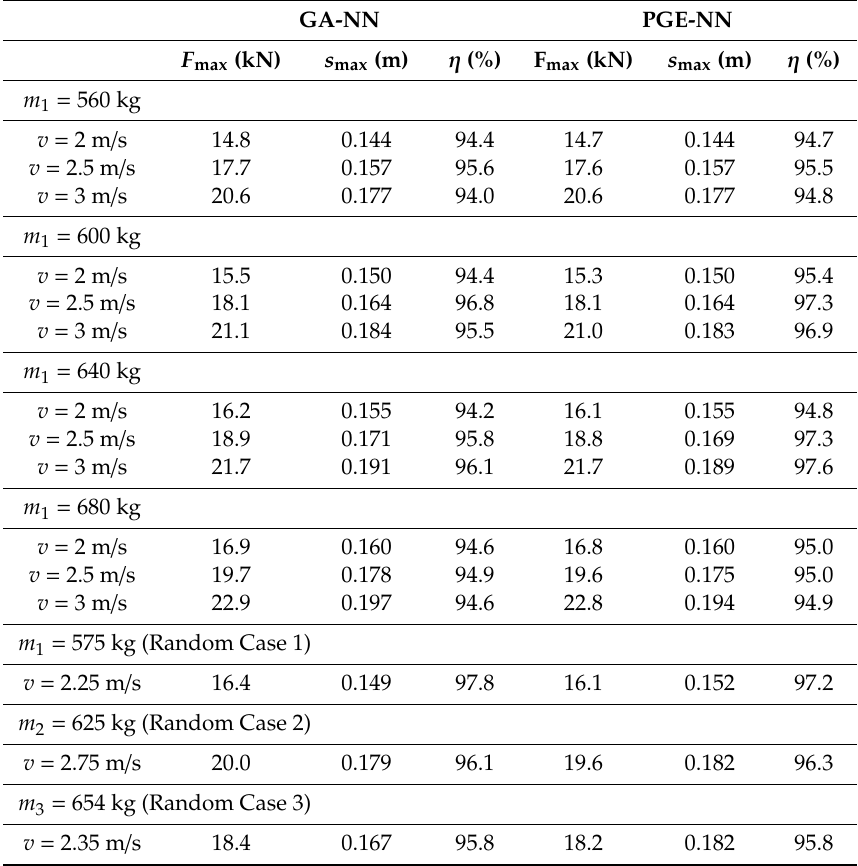
Table 6. Damper performance of the damper using GA-NN and PGE-NN in di ff ering landing cases. GA-NN